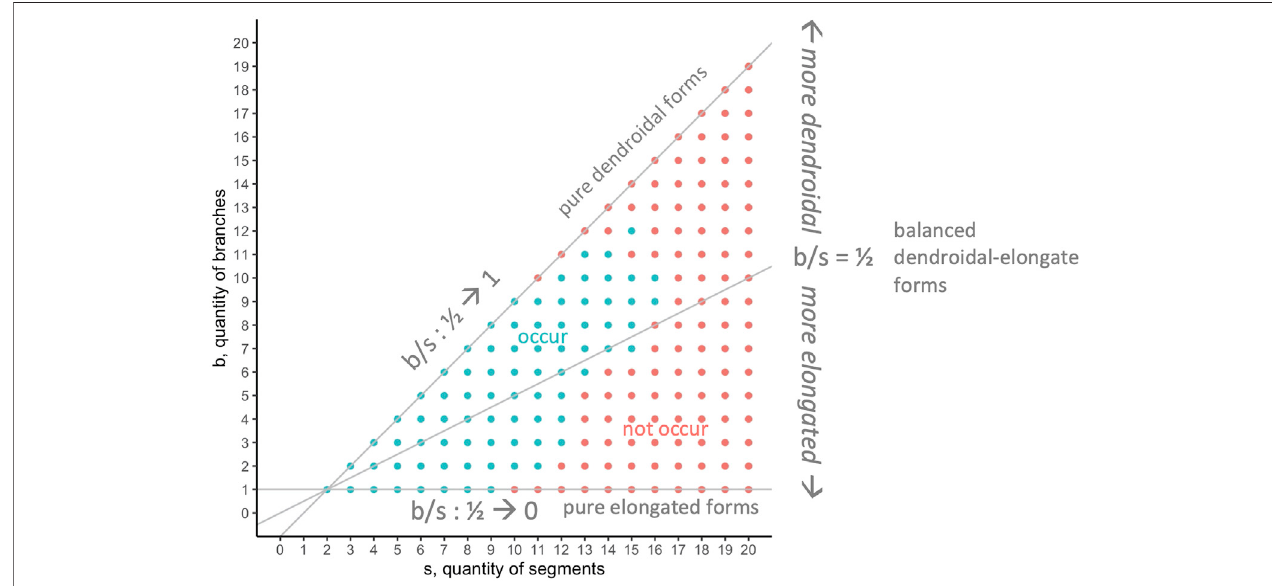
FIGURE 9| Morphospace analysis: occurrence of s - b body forms. Of all possible body forms, only aportion of the possible forms (aqua) evolved in9 populations, 100 generations, and 11 different conditions of mutation (594,000 individuals).